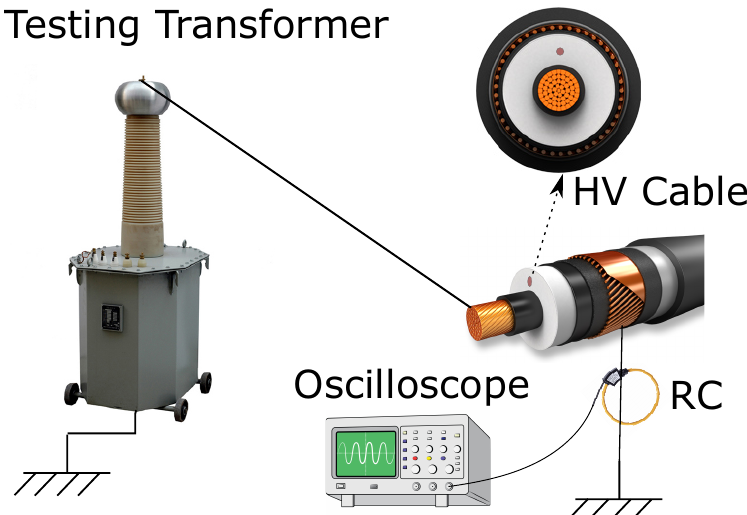
Figure 5. Laboratory setup. A testing transformer is connected between the cable conductor and the sheath. A Rogowski coil is connected across the connection with the sheath.